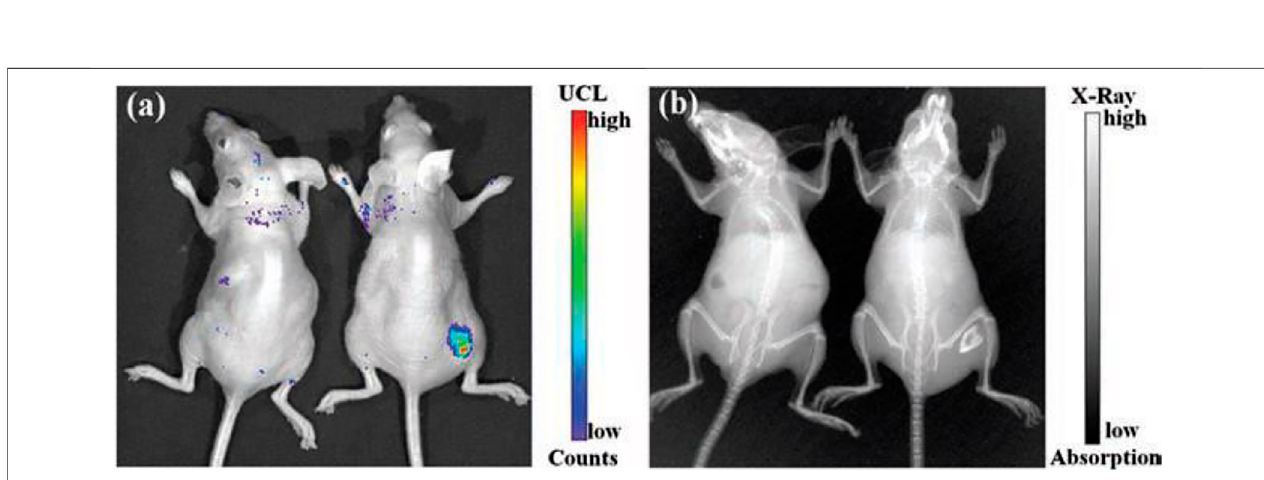
Frontiers in Chemistry |